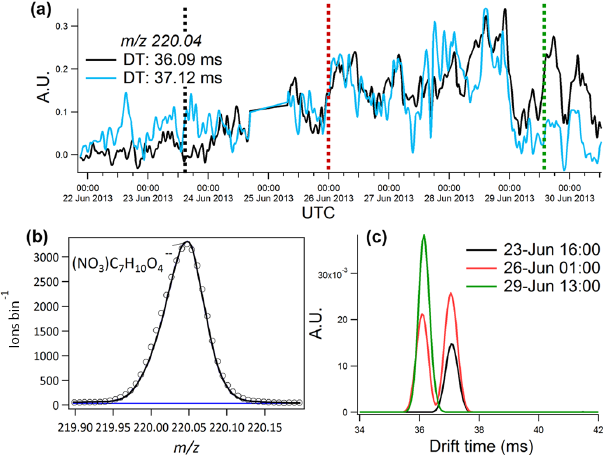
Figure 8. Panel (a) is a time series of two isomers observed in ion mobility space in the high-resolution (HR) mass spectral fit for the identified HOM (Ehn et al., 2012), C 7 H 10 O 4 (detected as a cluster ) , produced from α -pinene ozonolysis. The HR peak (b) for of NO − 3 this mass is fit by a single (NO 3 ) C 7 H 10 O − species. Panel (c) shows 4 the ion mobility spectrum for C 7 H 10 O 4 at three different points in the time series. IM spectra shown are obtained after postprocessing of the raw multiplexed ion mobility